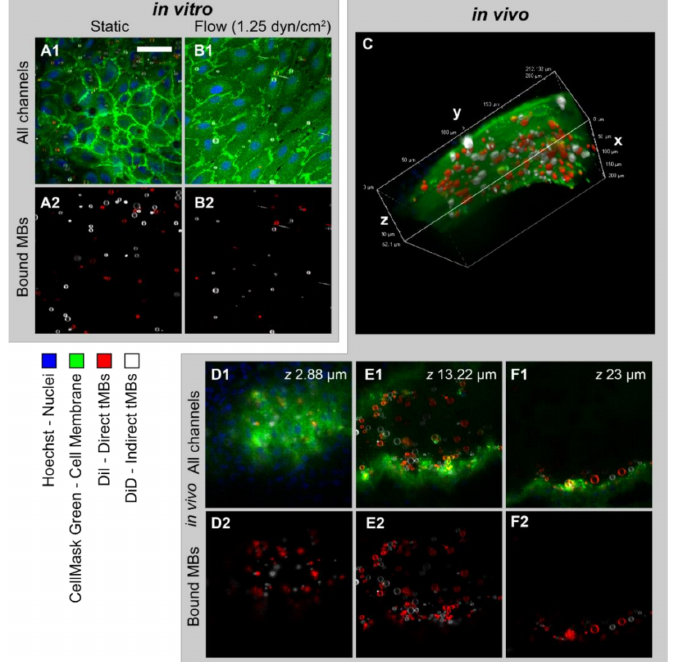
Figure 2. Typical examples of targeted microbubbles bound to a monolayer of HUVECs cultured ( A1 , A2 ) statically or ( B1 , B2 ) under flow (cultured at 7.5 dyn/cm 2 , imaged at 1.25 dyn/cm 2 ) showing ( A1 , B1 ) all channels and ( A2 , B2 ) DiI and DiD channels. ( C ) Volume view of targeted microbubbles bound to endothelial cells in vivo in the CAM model based on confocal z -stack. ( D1 – F1 , D2 – F2 ) 2D view of slices at different z positions in z -stack shown in ( C ) and imaged from the top, showing ( D1 – F1 ) all channels and ( D2 – F2 ) DiI and DiD channels. Cell membrane shown in green, cell nuclei in blue, direct microbubbles in red (DiI) and indirect microbubbles in white (DiD). Scale bar represents 50 µ m and applies to all 2D images. Normalized ratio of indirect/direct bound microbubbles was ( A1 , A2 ) 1.87, ( B1 , B2 ) 3.09, ( C ) 1.14. All experiments were performed in a temperature-controlled water bath at 37 ◦